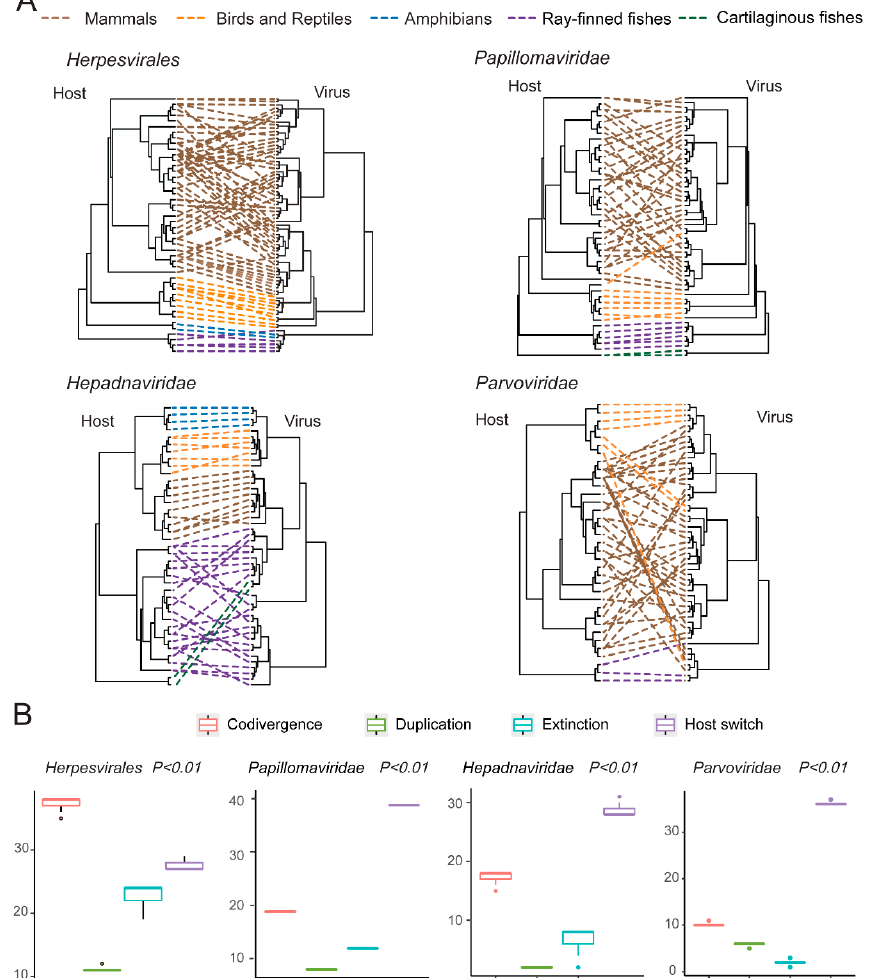
Figure 6. Codivergence relationships between vertebrate hosts and their associated DNA/RT viruses. ( A ) Comparison of the virus and host phylogenetic structures for herpesviruses, papillomaviruses, hepadnaviruses, and parvoviruses. More detailed presentations containing taxon labels are shown in Supplementary Figures S1–S4. ( B ) The box plot showing the estimation of codivergence events across the phylogeny of vertebrate-associated DNA viruses. Each box plot has the estimated median (center line) and upper and lower quartiles (box limits).